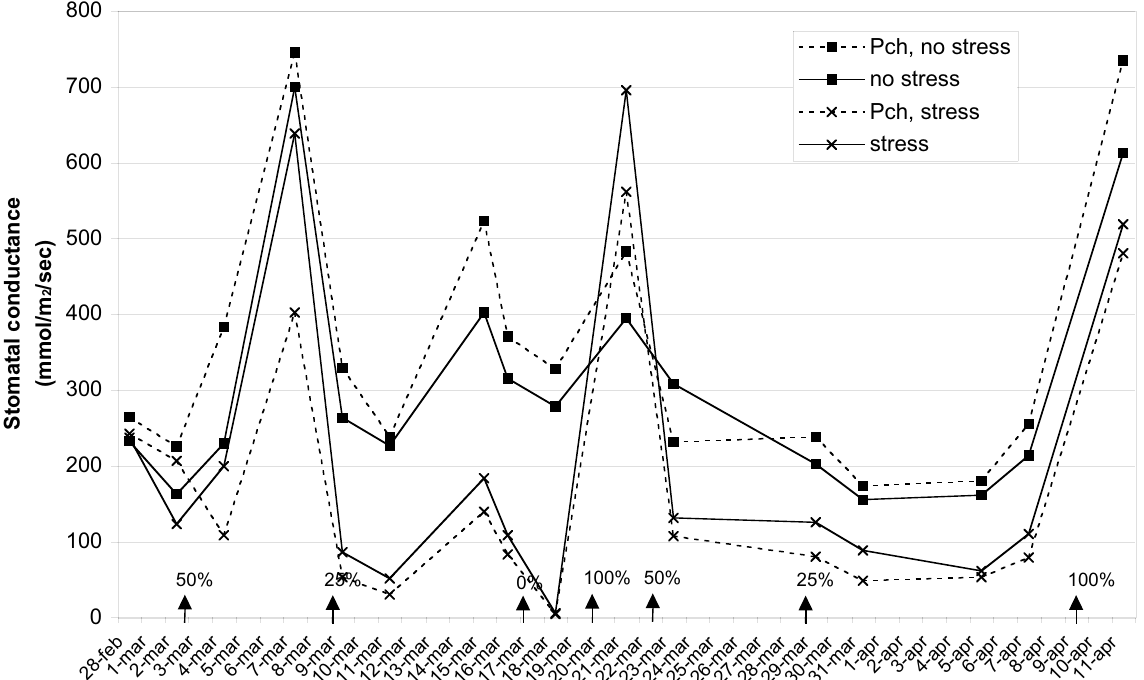
Fig. 5. Effects of water stress on stomatal conductance of infected and uninfected Zinfandel, Year 2,